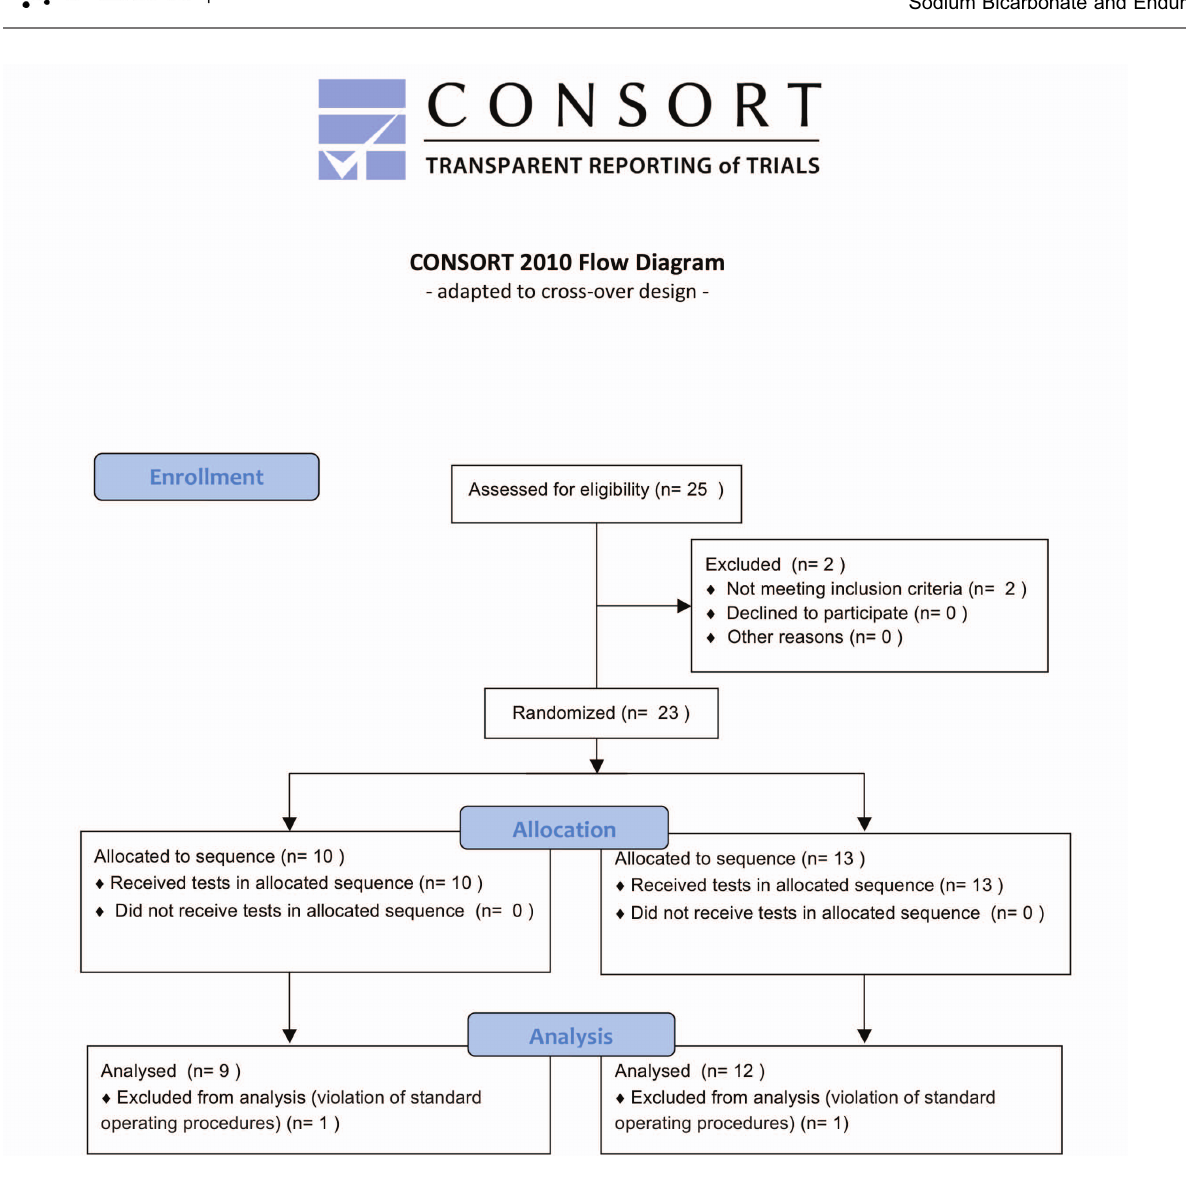
Fig. 2. Flow of participants through the